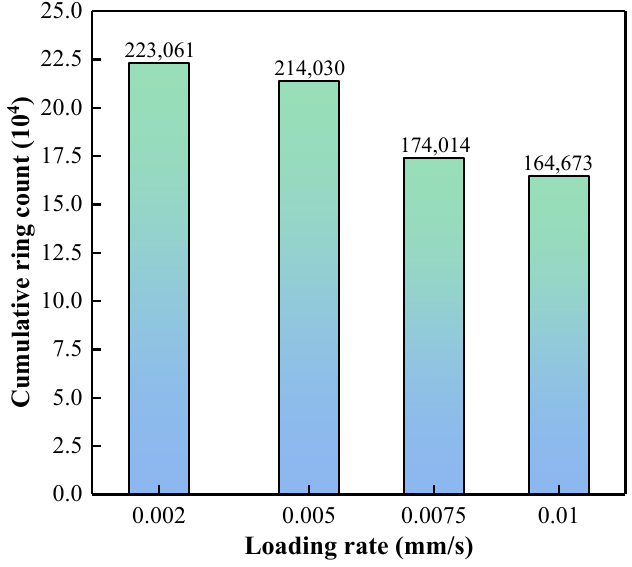
Figure 9. Relationship between cumulative ringing count and loading rate.